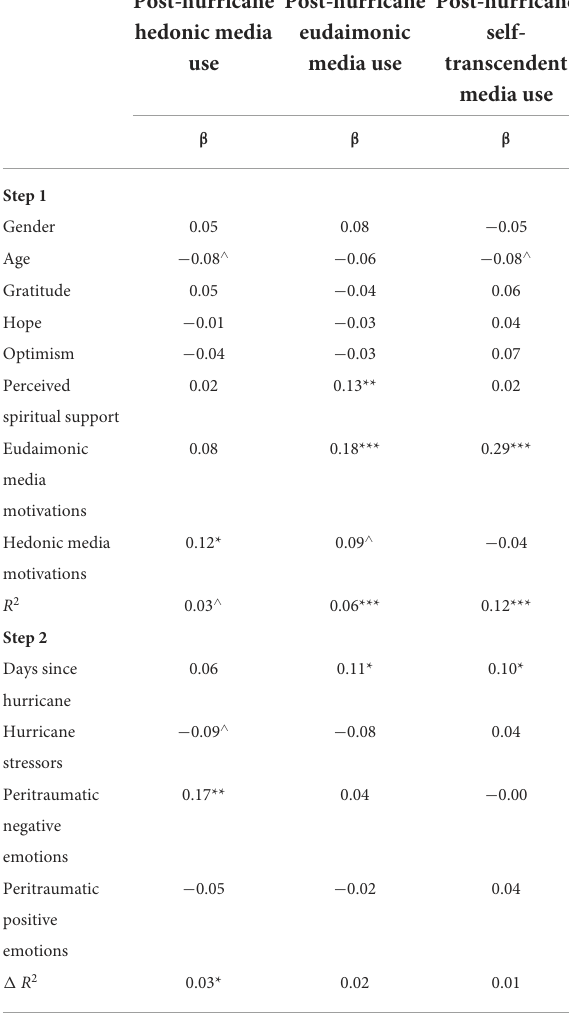
TABLE 2 Hierarchical regression on post-hurricane media